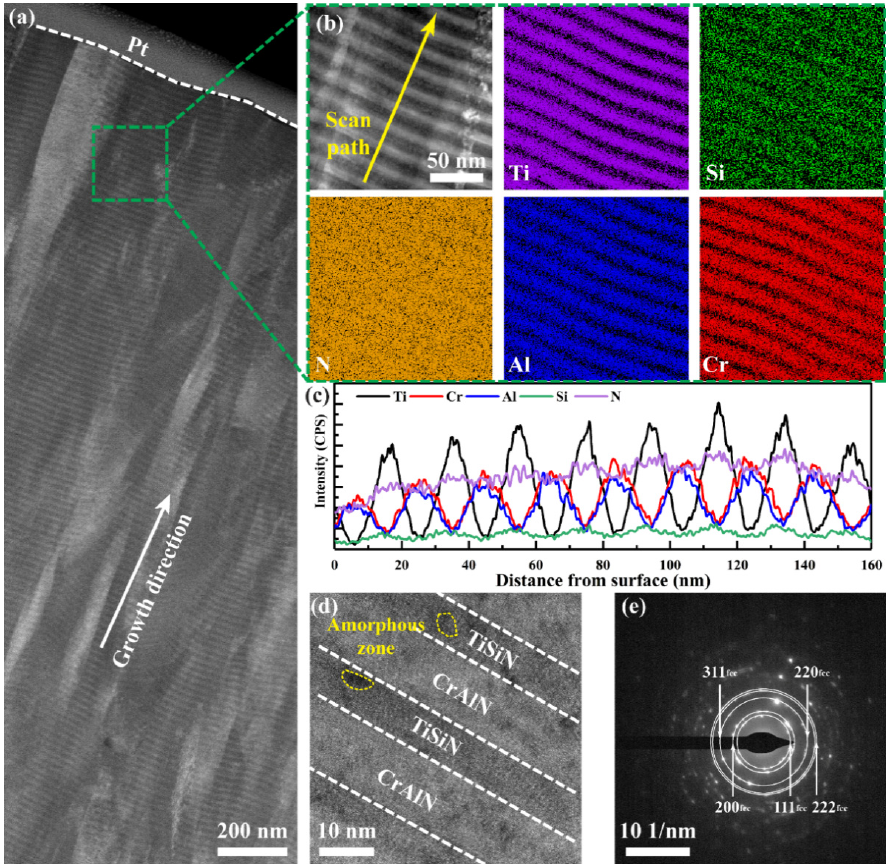
Figure 5. Cross − sectional TEM morphology of CrAlN/TiSiN nanomultilayer: ( a ) Low magnification TEM image; ( b ) EDS mapping of typical elements; ( c ) EDS line scan along scan path in ( b ); ( d ) HRTEM images; ( e ) Indexed SAED of ( d ).